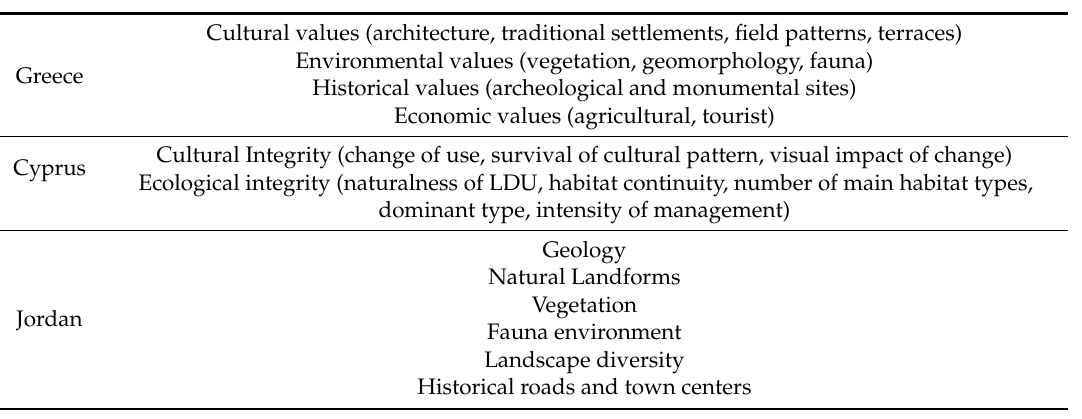
Table 3. Partners’